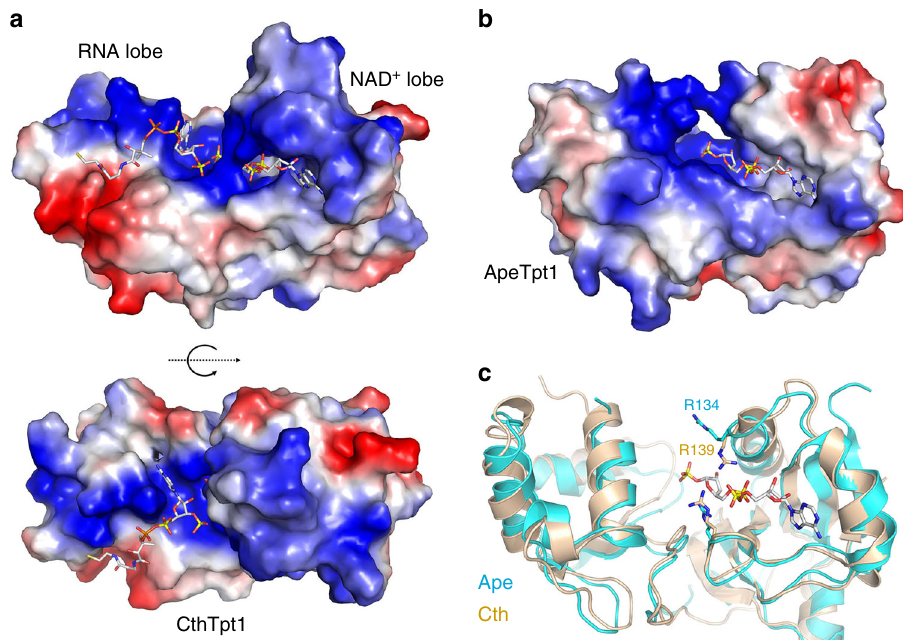
Fig. 4 Surface electrostatics and comparison to ApeTpt1 apoenzyme. a Surface electrostatic model of the CthTpt1 protein generated in Pymol. ADP-ribose- 1 ″ -PO 4 and CoA ligands are depicted as stick models. The top view highlights positive potential (blue) across the RNA and NAD + lobes surrounding the ligands, with ADP-ribose-1 ″ -PO 4 being encased below an “ arch ″ formed by two arginines. The bottom view shows the adenine of pAp wedged into a groove on the positive surface. b Surface electrostatic model is shown of the Aeropyrum pernix (Ape) Tpt1 apoenzyme (pdb 1WFX) with ADP-ribose-1 ″ -PO 4 imported from the CthTpt1 structure. c Superposition of the CthTpt1 (beige) and ApeTpt1 (cyan) structures. The arginines that form the arch over ADP- ribose-1 ″ -PO 4 in CthTpt1 are shown as stick models. Side chain movement of ApeTpt1 Arg 134 versus CthTpt1 Arg139 gives access to the NAD +